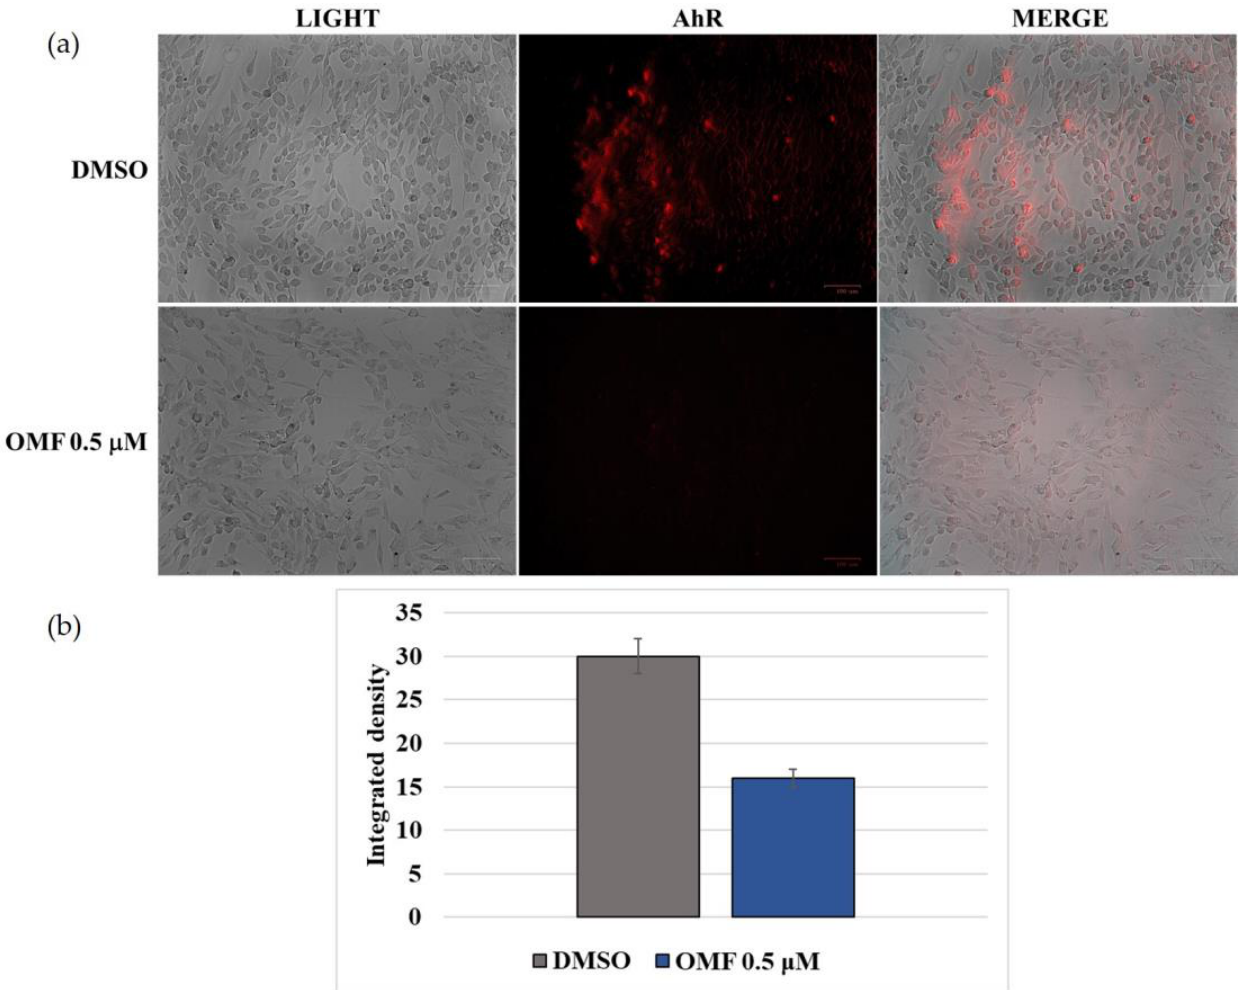
Figure 6. OMF downregulated the expression of AhR. ( a ) A72 uninfected group expressed AhR. OMF at a concentration of 0.5 μ M markedly reduced the expression of AhR. Scale bar 100 µm. ( b ) Bars indicate the mean ratio produced from the integrated density in the expression of AhR assessed using ImageJ. Error bars correspond to standard error quantification.